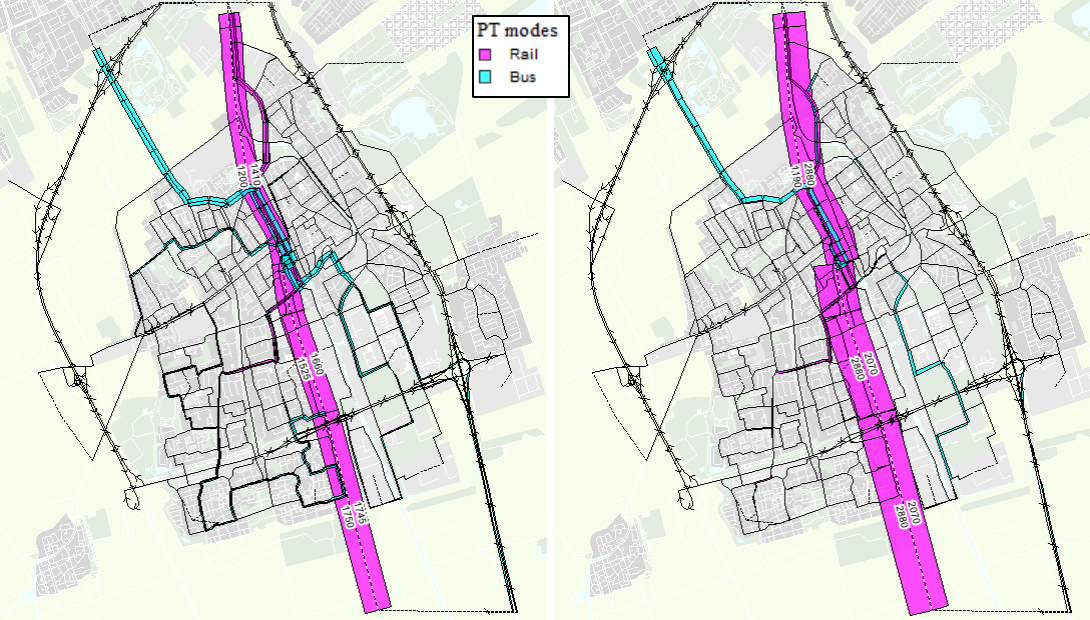
Figure 8. Average public transport flows (h -1 ) between 17:30 and 18:00 for the Delft case study (a) on a normal day (b) in the evacuation scenario Bar widths are proportional to flow, colors indicate public transport